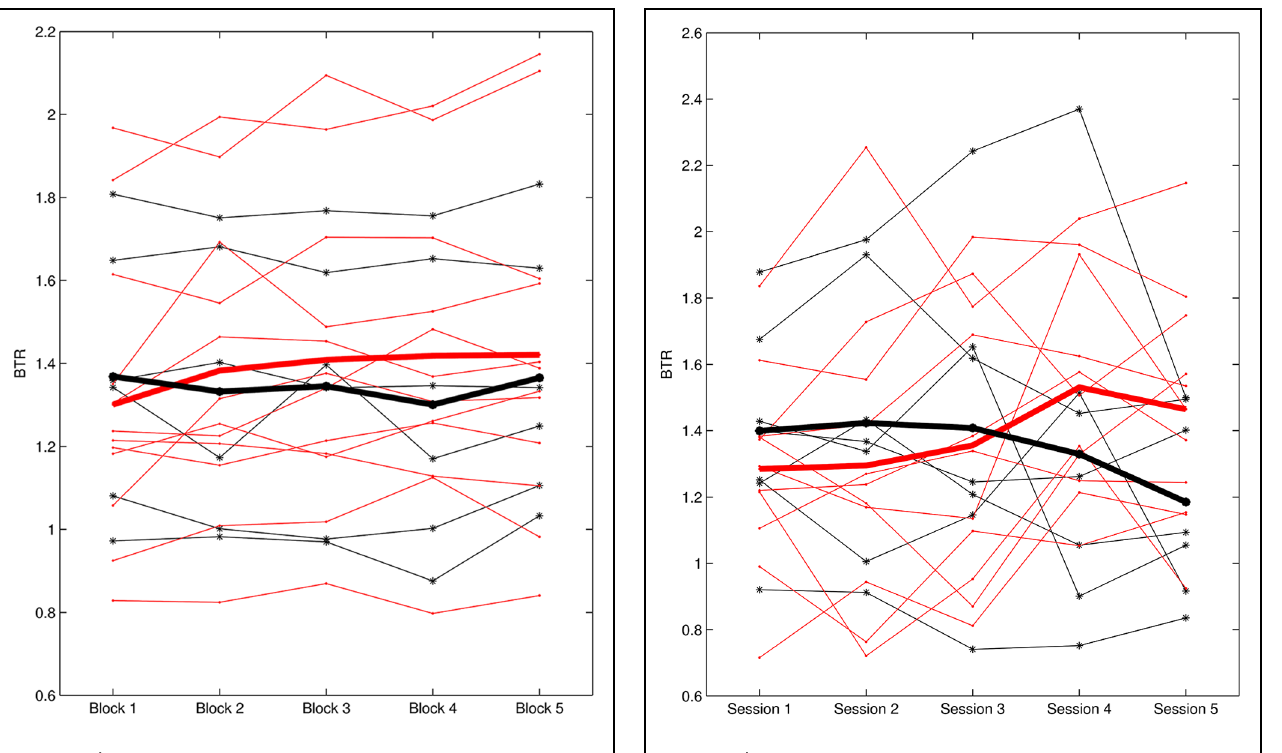
p = 0.007]. Due to beta-1 in Block 1 of Session 1 had one